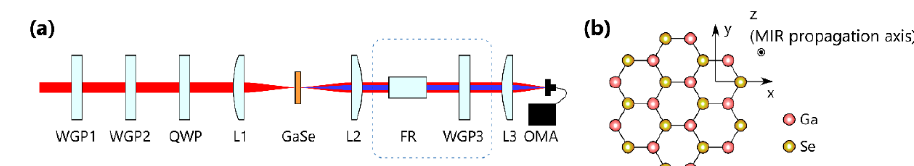
Fig. 1. (a) Schematic of the experimental setup (WGP, wire grid polarizer; QWP, quarter-wave plate; L, lens; FR, quarter-wave Fresnel rhomb retarder; OMA, optical multichannel analyzer). Optics in dotted lines are used for polarization analysis. (b) Crystal structure of GaSe. The MIR beam is propagated along the